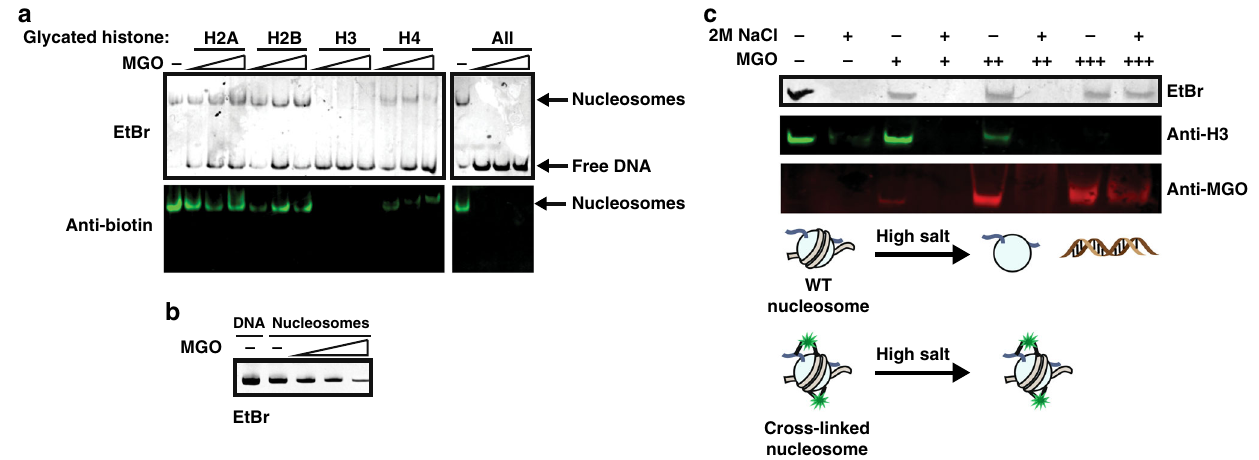
Fig. 3 Histone glycation disrupts nucleosome assembly and stability. a Histones were treated as described in Fig. 2a before used in nucleosome assembly with salt dialysis in the presence of a strong nucleosome positioning DNA sequence ( ‘ 601 ’ ). Samples were separated on a native gel that was either stained with intercalating agent (EtBr) (top) or transferred and western blotted with anti-biotin (bottom). b Nucleosomes were treated with 0, 2, 30 or 100 mM of MGO (corresponding to 1:8, 1:120 or 1:400 sites:MGO stoichiometry, respectively) for 12 h at 37 °C and then used as templates in a PCR reaction. Products were separated on a 1 % agarose gel and stained with EtBr. c Top: histone-DNA glycation mediated cross-linking was examined using the sensitivity of unmodi fi ed nucleosomes to high salt treatment. Nucleosomes were treated with 0, 0.5, 5 or 100 mM of MGO (corresponding to 1:2, 1:20 or 1:400 sites: MGO stoichiometry, respectively) for 72 h at 37 °C after which they were either untreated or treated with 2 M NaCl. Samples were then separated on a native gel and either imaged by EtBr or transferred and analyzed by western blot with the indicated antibodies. Bottom: Schematic representation of untreated versus 100 mM MGO-treated nucleosomes before and after high salt